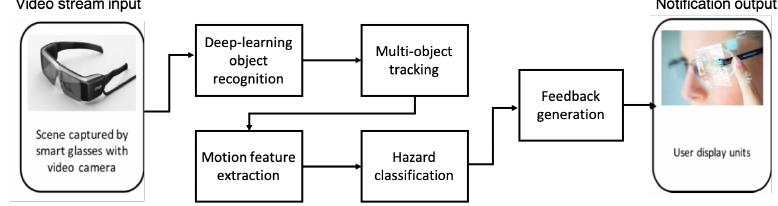
Figure 6. System overview including the project’s main